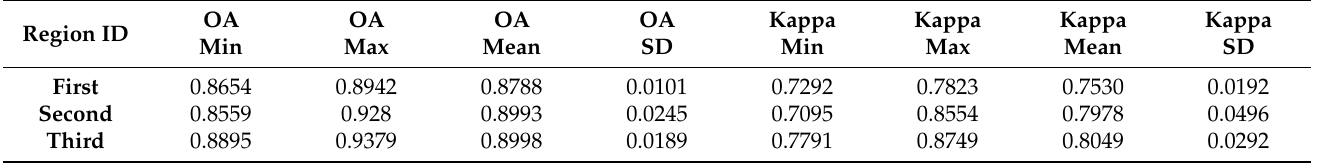
Table 4. The results of the 3-fold